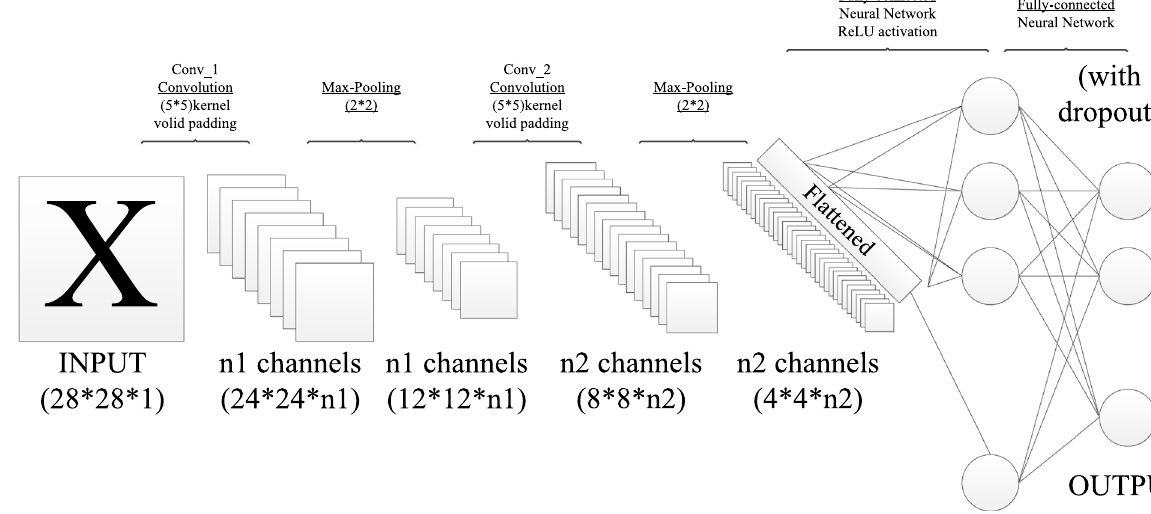
Fig. 1 Convolutional neural network